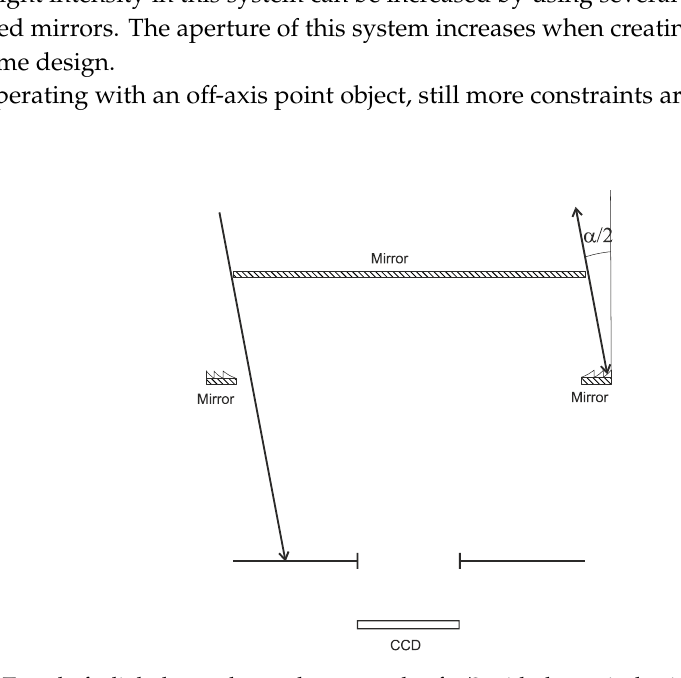
Figure 2. Travel of a light beam that makes an angle of α / 2 with the optical axis through the objective.